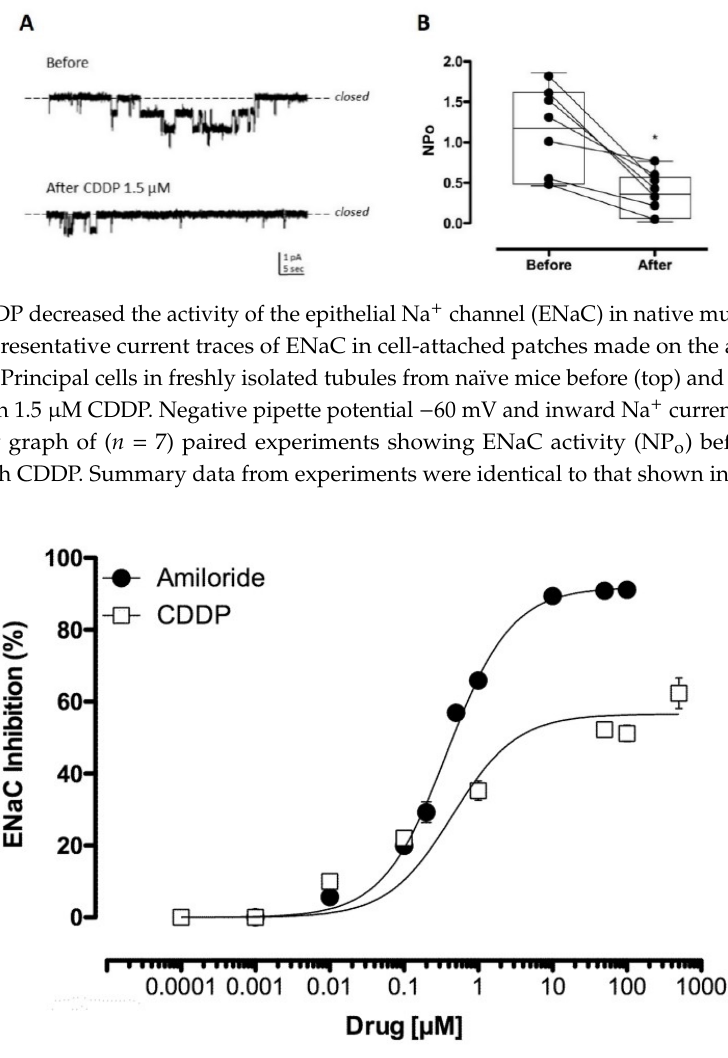
Figure 3. CDDP is a partial inhibitor of ENaC. Summary graph of the dose-dependent inhibitory effects of amiloride (black circles) and cisplatin (white boxes) on mENaC expressed in Chinese Hamster Ovary (CHO) cells ( n = 3–5). CDDP significantly reduced ENaC activity with a reduced Emax compared with amiloride.